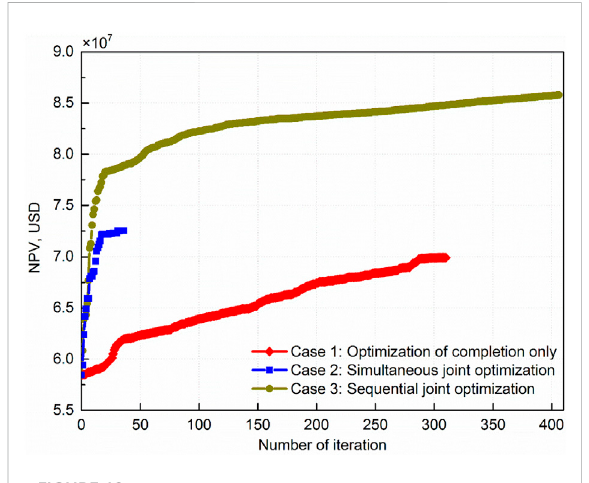
FIGURE 12 Objectivefunctionvalue versus numberofiterationsforthree optimization cases in the fi eld application.